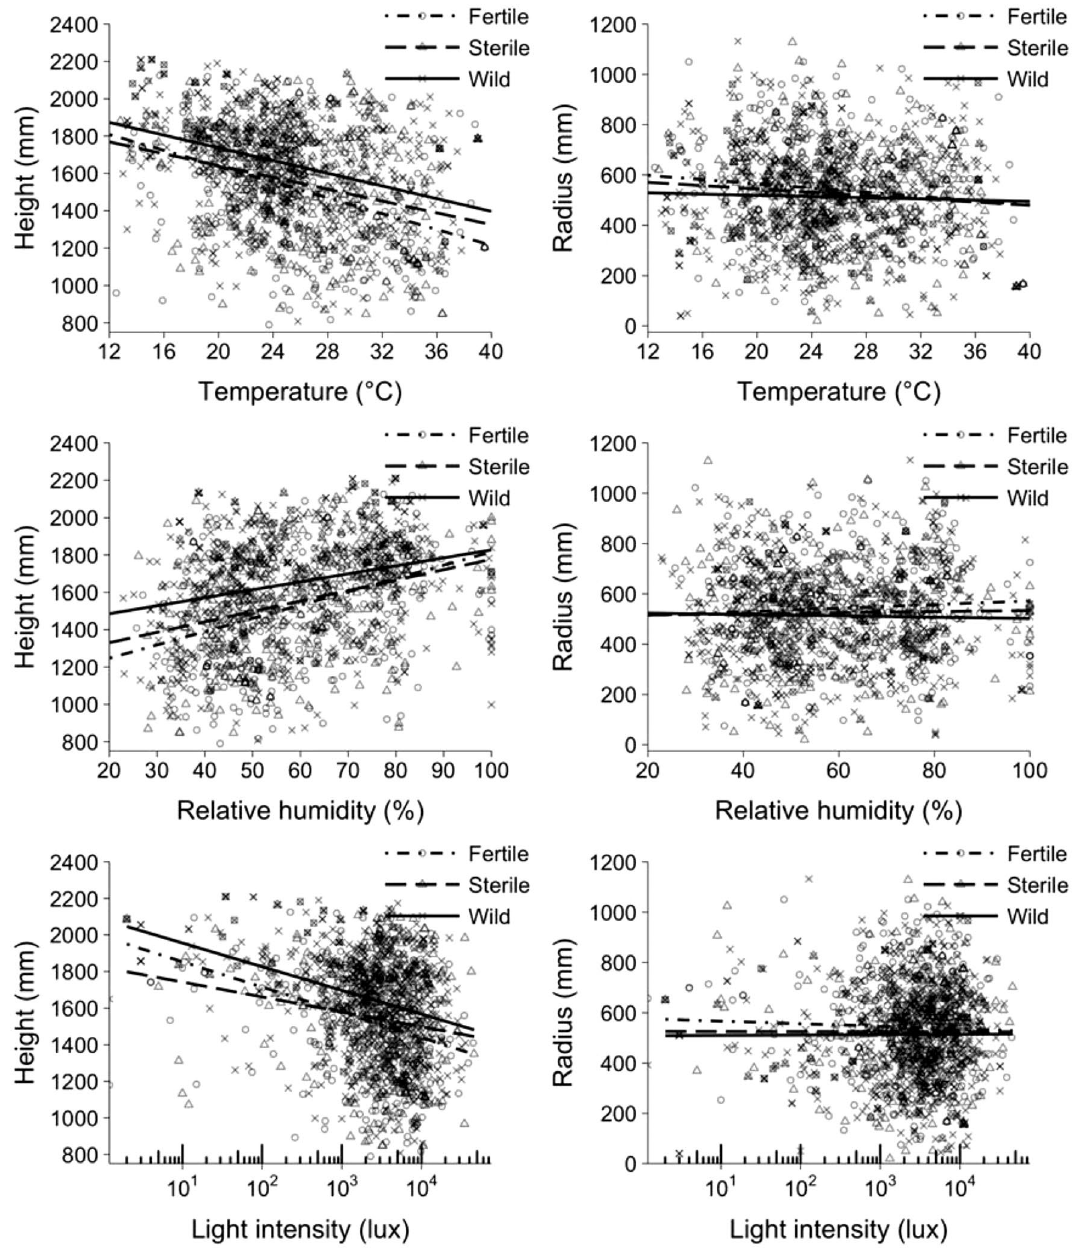
Figure 1. Distance from the ground (height) and distance from the canopy center (radius) of fertile mass- reared, sterile mass-reared and wild flies observed in Citrus tree canopies. Temperature, relative humidity, and light intensity were recorded from leaf surfaces where flies were located. Fitted lines represent mean heights or radii of the three fly in canopies 74 . Other sources of nutrients (e.g., bird droppings, honeydew, leaf exudates 75 ) may also fall from higher regions of the canopy and accumulate on the top sides of leaves. Bacteria and fungi on leaf surfaces have been suggested as a source of protein for adult fruit flies 76–78 . Bacterial and fungal colonies typically proliferate in microclimates with higher humidity, moderate temperature, and limited solar radiation 79–81 . These conditions were typical of locations lower in the tree canopies that we measured, and therefore may have contained bacteria and fungi that are typically consumed by B. tryoni 82–86 . It is possible that beneficial bacteria and fungi are found predominantly on the top surfaces of leaves, although no studies have described the microbial foods of fruit flies with regards to leaf surface or canopy location. Flies of all types in this study moved lowest in the canopy when feeding from leaf surfaces, which allowed them to remain in the shade while feeding on the top of leaves. While light intensity differed between the tops and bottoms of leaves, we found no differences in temperature or relative humidity between top or bottom leaf boundaries. It is possible that more sensitive measuring devices (e.g., thermocouples, thermistors), which are designed to measure the conditions on actual leaf surfaces and not